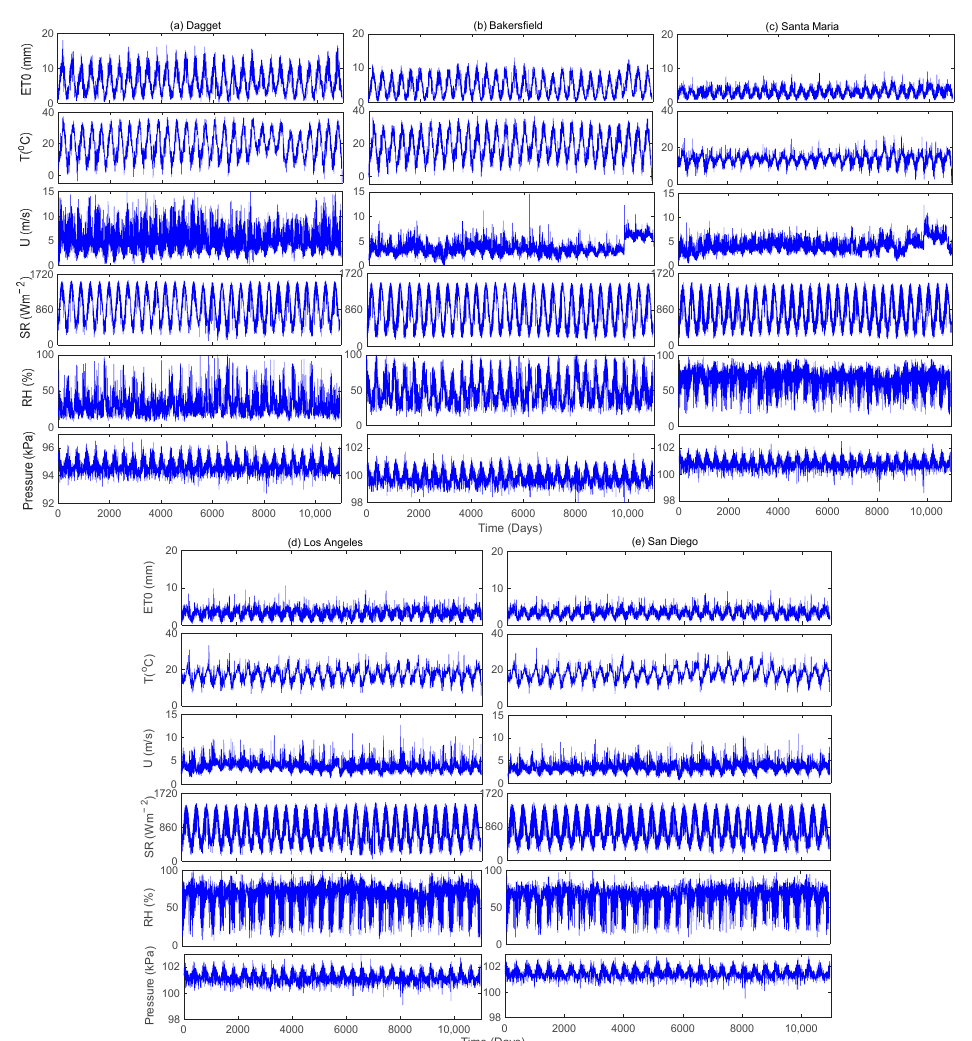
Figure 2. Time series plots of agro-meteorological datasets of different stations in California: ( a ) Dagget; ( b ) Bakersfield; ( c ) Santa Maria; ( d ) Los Angeles; ( e ) San Diego.